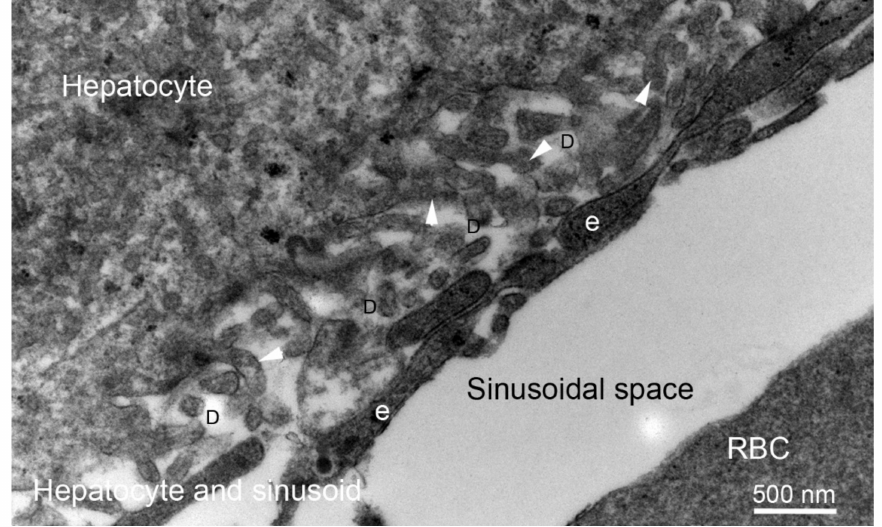
Figure 9. TEM of normal liver in the rabbit. No BM is associated with hepatocytes, endothelial cells (e), vascular channel sinusoids or spaces of Diss é (D). The hepatocyte has processes (arrowheads) that extend into the space of Diss é . The sinusoids have a discontinuous, highly fenestrated endothelial lining. Neither the hepatocytes nor endothelial cells have BMs that separate them from the space of Diss é . Mag. 30,000 × . Reprinted with permission from Saikia et al. Cell and Tissue Res,